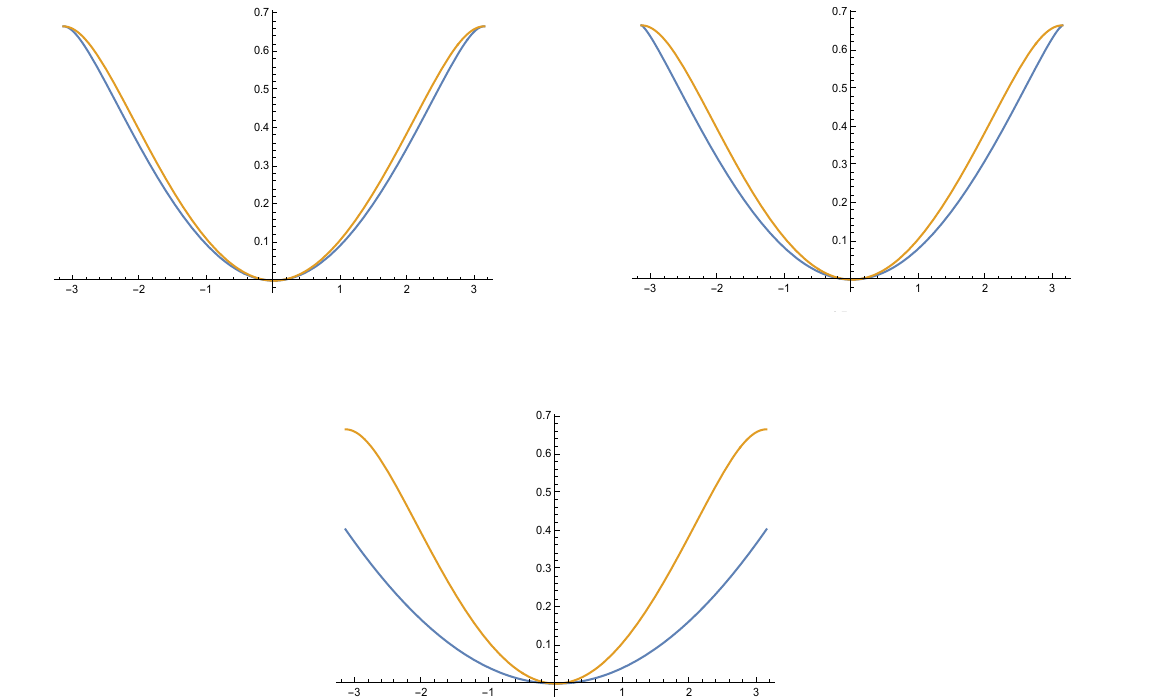
Figure 9 . Comparing the conventional axion potential (yellow curves) with the \exact" one (blue curves) for N f = 2 ; (cid:22) 2 = 2 (cid:22) 2 and at three values of (cid:22) 2 =a : 0 : 25 ; 0 : 5 (critical value) ; 2 : 5. In the u u d (cid:12)rst two cases the two potentials (but not necessarily their derivatives) agree at (cid:16) = (cid:6) (cid:25) while in the third (overcritical) case even the values of the potentials disagree at the boundary of the periodicity interval.